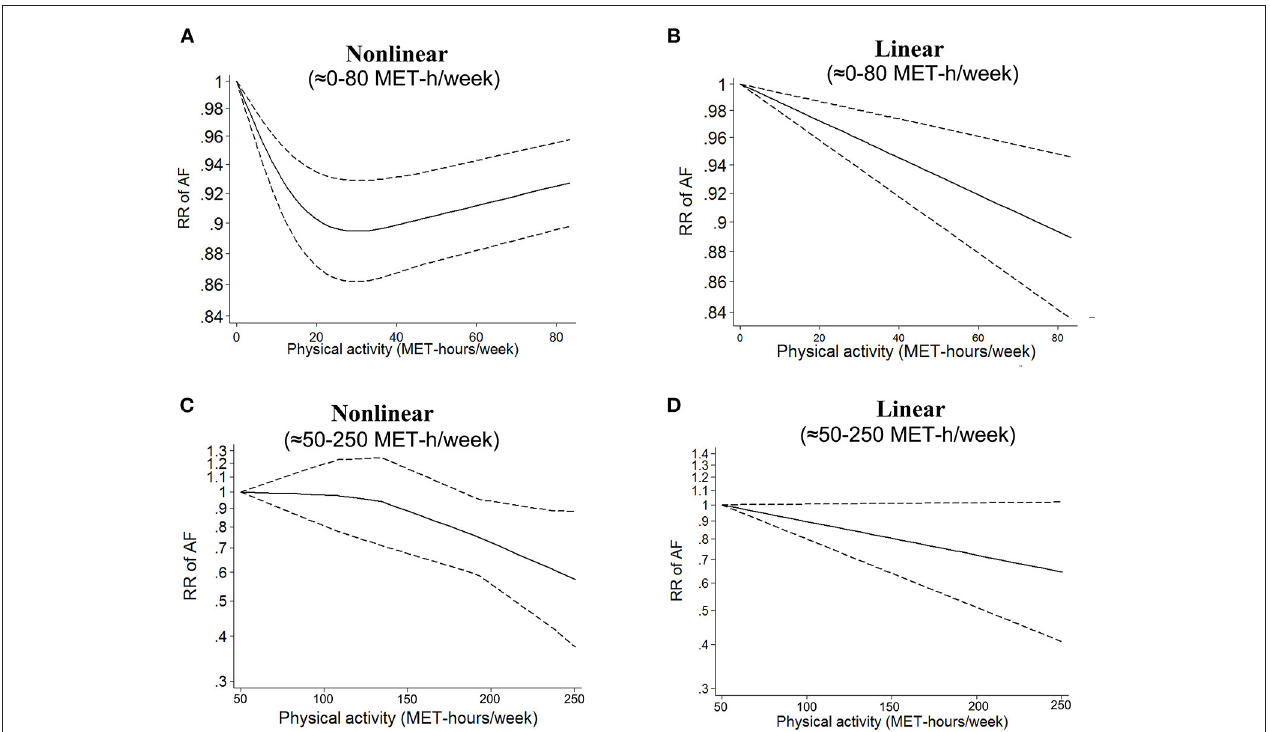
FIGURE 2 | Dose–response analysis of physical activity and atrial fibrillation in the total population. (A,B) Non-linear and linear models of PA and AF in the range of 0–80 MET-h/week. (C,D) Non-linear and linear models of PA and AF at the high level of PA. The bold and dashed lines represent the estimated RR and 95% CI, respectively. The non-linear models were fit by using a restricted cubic spline. PA, physical activity; AF, atrial fibrillation; RR, risk ratio; CI, confidence interval.